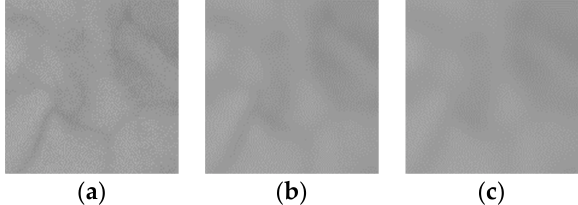
Figure 4. Palm vein image from 850 nm with different TPAVs after filtering. ( a ) TPAV = 20.2188 from the original ROI; ( b ) TPAV = 8.7939 with δ = 1.8; ( c ) TPAV = 1.7296 with δ = 2.6.